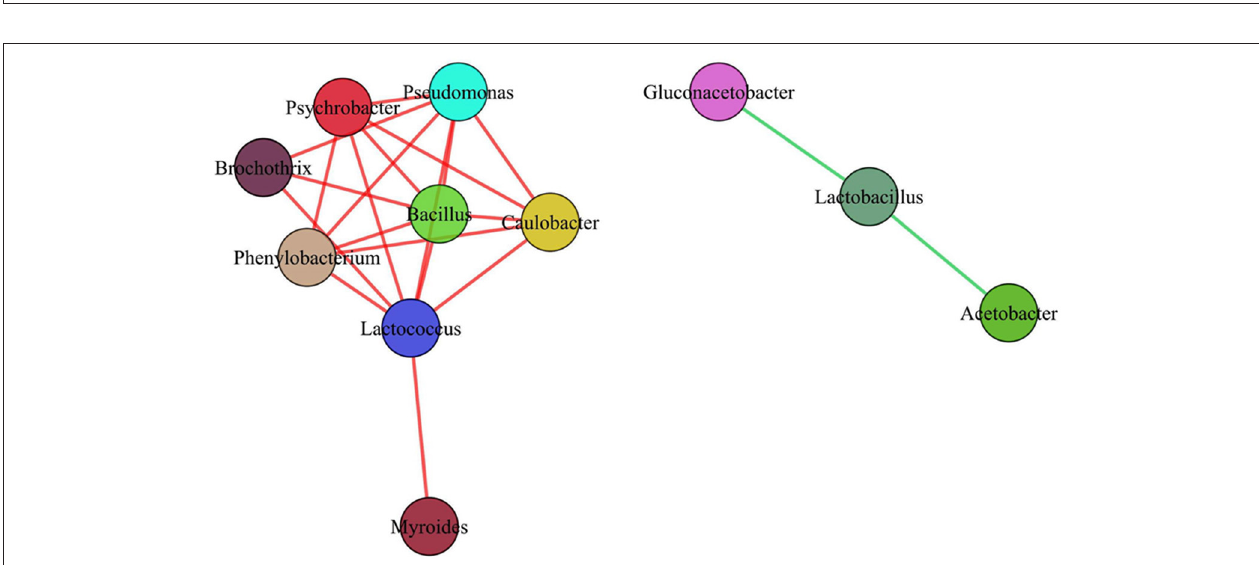
FIGURE 10 | Venn diagram analysis of the logic relationships of the OTUs identified in the different samples. The left panel represented the OTUs from the samples fermented with different cereal grains, A: millet and a small amount of rice; B: millet; C: white proso millet; and D: red proso millet. The right panel represented the OTUs from the samples from two different counties: group A and B from Pianguan county, and group C and D from Hequ county.